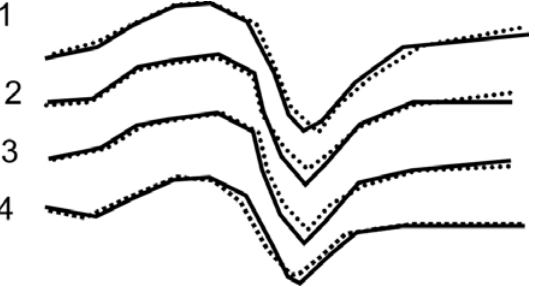
Figure 16. Cu 2+ (I) EPR spectra of SC Y dashed line, and nanocomposites (solid line). 1–15% PS and 85% ceramics, 2–15% PMMA and 85% ceramics, 3–20% PE and 80% ceramics, 4–15% copolymer of ST and MMA and 85%